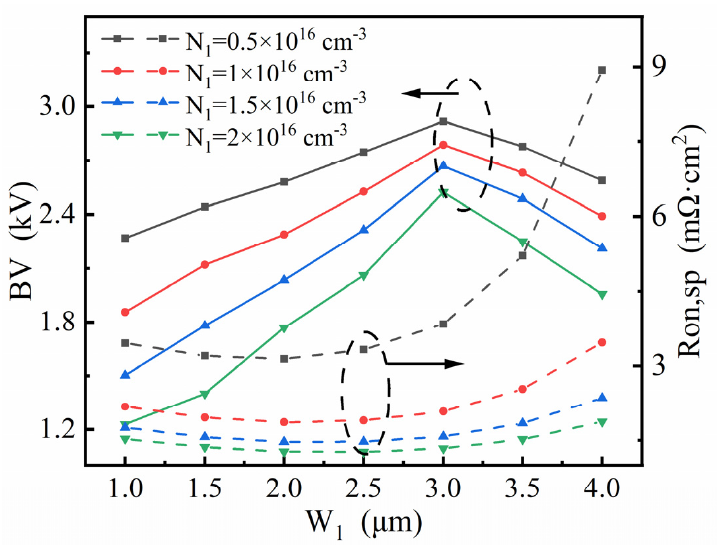
Figure 8. Investigation of W 1 affecting optimized BV and R on,sp in SDS-Trench CAVET for varied values of N 1 for a given N s = 2 × 10 16 cm − 3 .